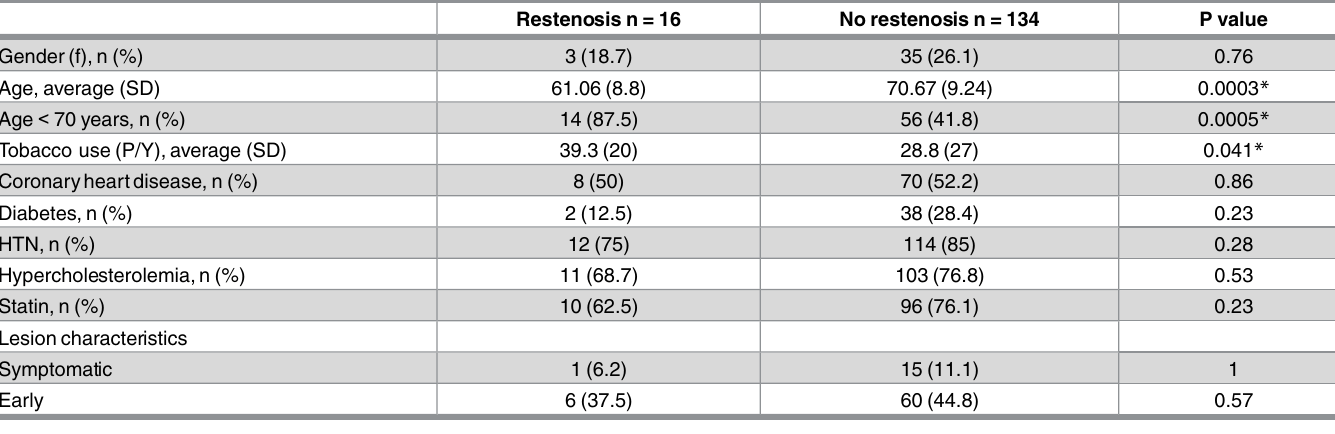
Table 3. Demographic and ClinicalRisk Factors: